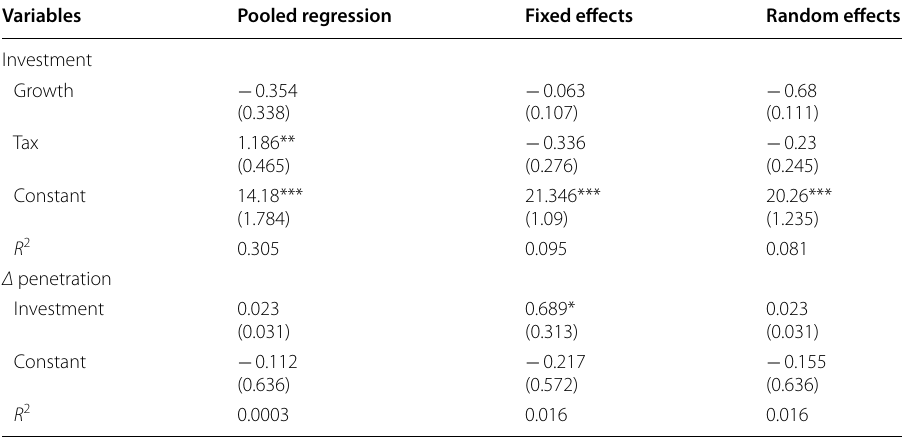
Table 4 Estimates of pooled, fixed effect and random effect 2SLS regressions (supply and infrastructure production